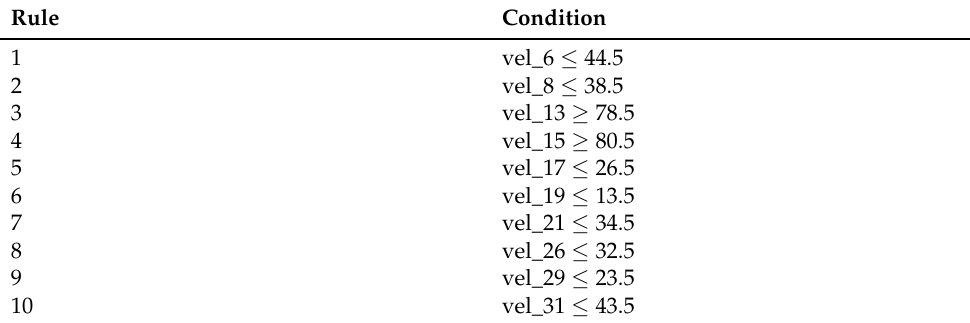
Table 13. Decision rule table for outlier time series.